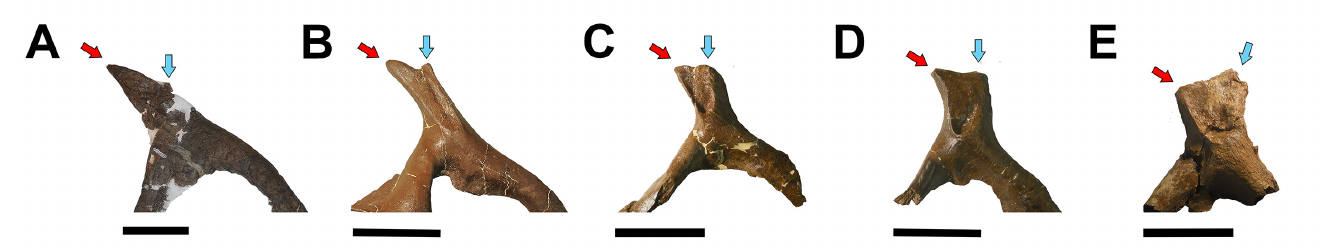
Figure 7. Stratigraphic trends in the nasal process of the premaxilla (NPP). A) TMP 2002.057.0007, the holotype of Eotriceratops , from the upper Horseshoe Canyon Formation of Alberta, which slightly predates the HCF (Wu et al. 2007; image mirrored). The NPP is narrow, strongly caudally inclined and exhibits two peaks (red and blue arrows). B) MOR 1122 7-22-00-1, from the base of the HCF. As in Eotriceratops , the NPP is forked; however, the peaks are more closely positioned. C) MOR 1120, Triceratops horridus from the upper part of the lower unit of the HCF (mirrored). D) MOR 3027, Triceratops sp. from the middle unit of the HCF (mirrored). E) MOR 2702, Triceratops prorsus from the upper unit of the HCF (mirrored). A, C−E modified from Scannella et al. (2014). Scale, 10